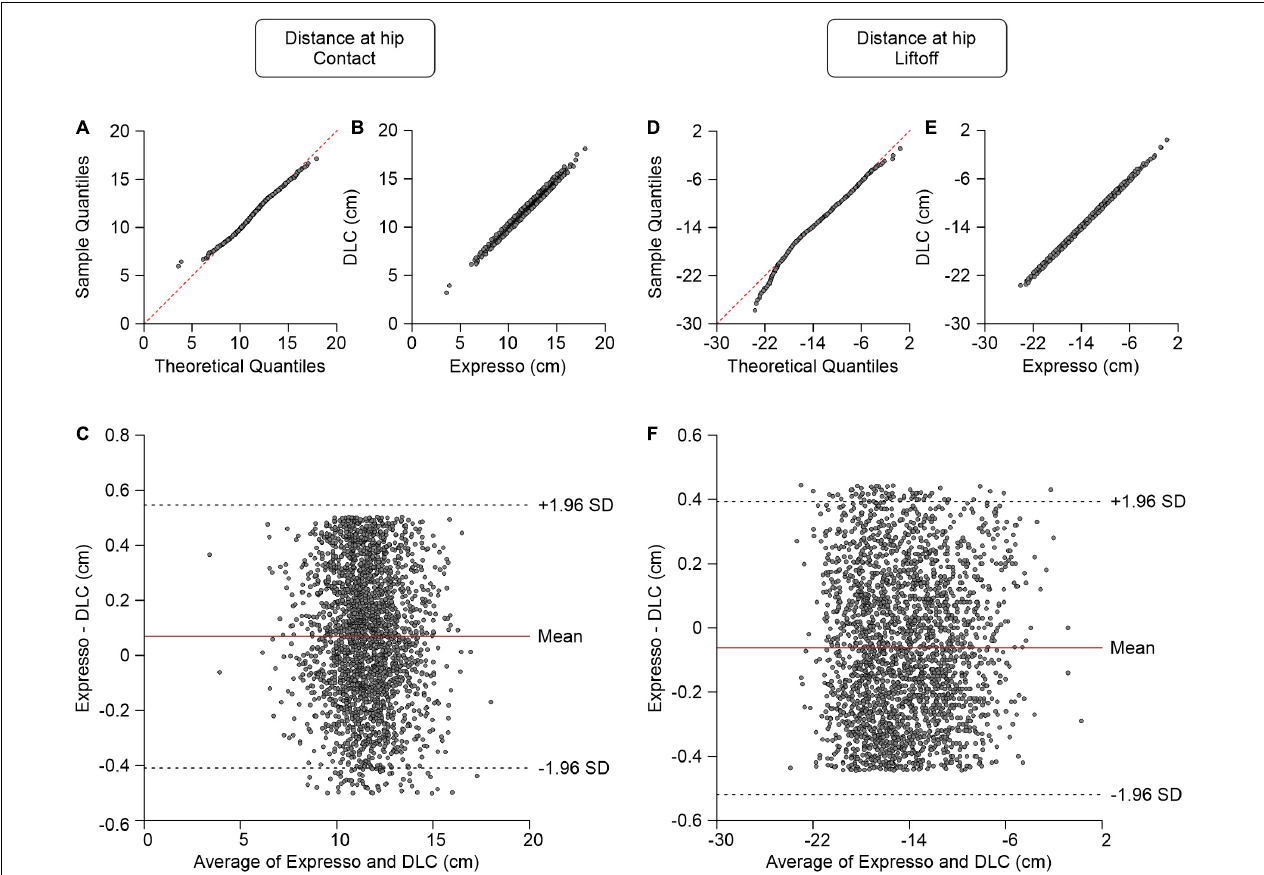
FIGURE 3 | Comparison of distance at hip at contact and at liftoff measured with data from Expresso and DLC. (A) Distance at hip at contact QQ-plot where the red dashed line represents a perfect normal distribution. (B) Distance at hip at contact scatter plot of values obtained with Expresso and DLC. (C) Bland–Altman plot of distance at hip at contact measurements from Expresso and DLC. The solid red line is the mean difference between the two methods and black dashed lines show ± 1.96 standard deviations. (D) Distance at hip at liftoff QQ-plot where the red dashed line represents a perfect normal distribution. (E) Distance at hip at liftoff scatter plot of values obtained with Expresso and DLC. (F) Bland–Altman plot of distance at hip at liftoff measurements from Expresso and DLC. The solid red line is the mean difference between two methods and black dashed lines show ± 1.96 standard